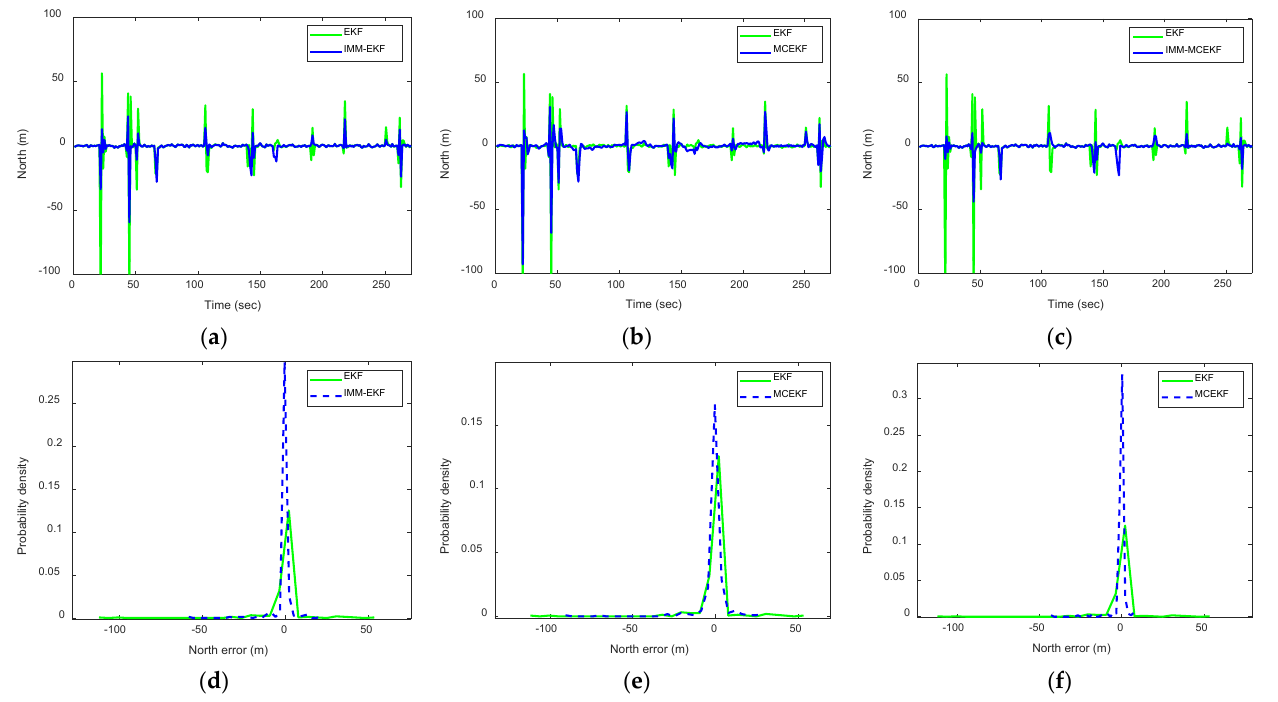
Figure 8. Comparison between the navigational accuracy and the corresponding pdfs of the north position errors: ( top ) navigational accuracies for EKF vs. ( a ) IMM–EKF, ( b ) MCEKF, and ( c ) IMM– MCEKF, and ( bottom ) pdfs of position errors for EKF vs. ( d ) IMM–EKF, ( e ) MCEKF, and ( f ) IMM– MCEKF.